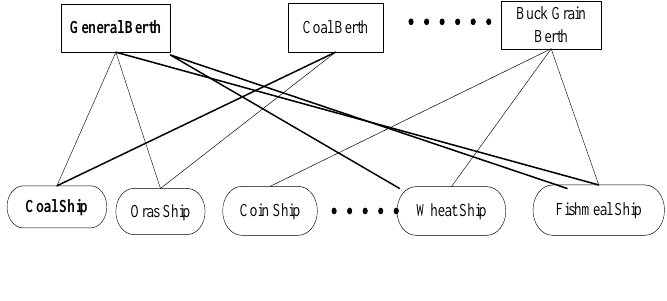
Figure 2. Relationship of ship and